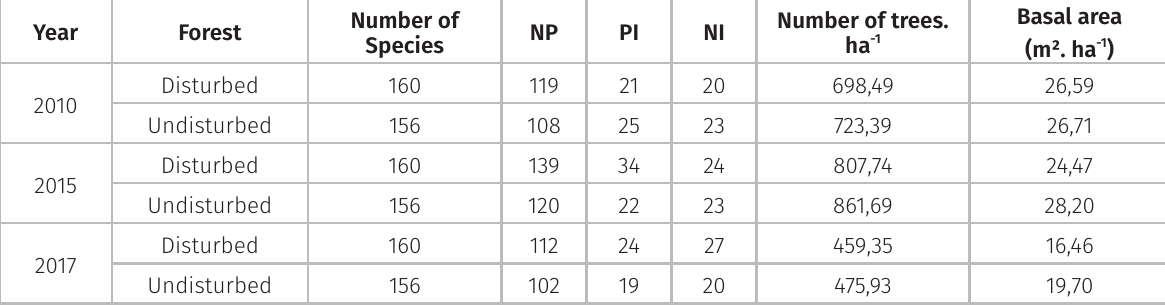
Table I. Richness and tree stock in monitoring period (2010-2017), Tapajós National Forest, Pará, Brazil.